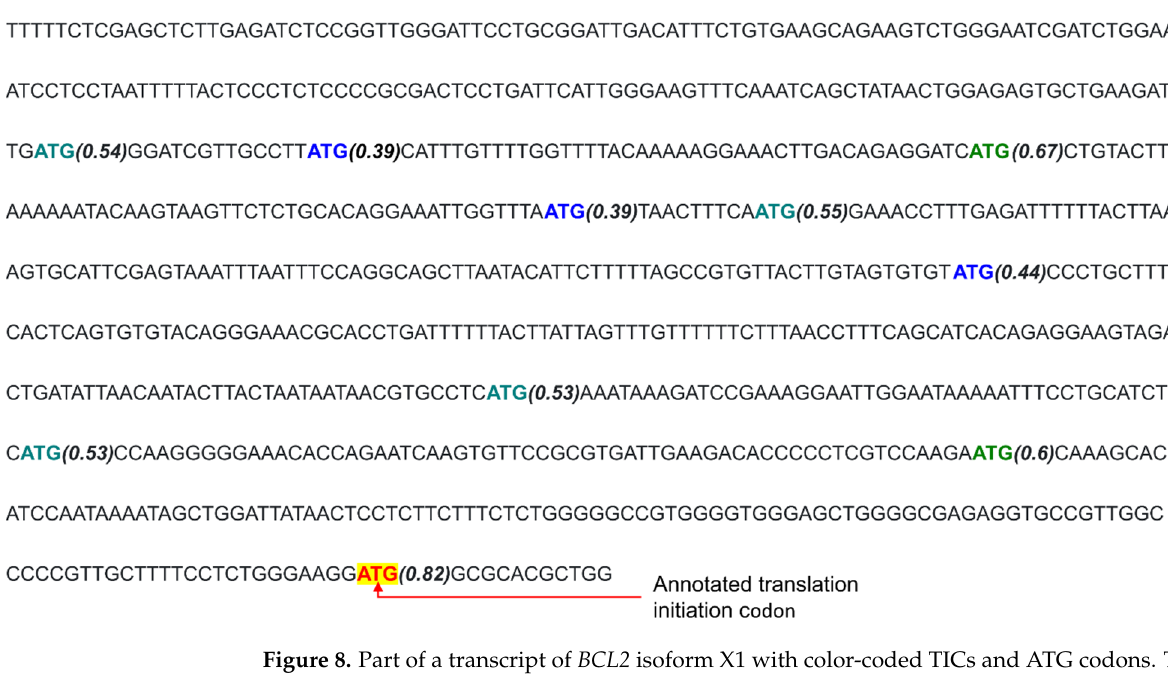
Figure 8. Part of a transcript of BCL2 isoform X1 with color-coded TICs and ATG codons. The TIC shown in red has a higher KSS than all ATGs in comparable parts of BCL2 isoform transcripts.